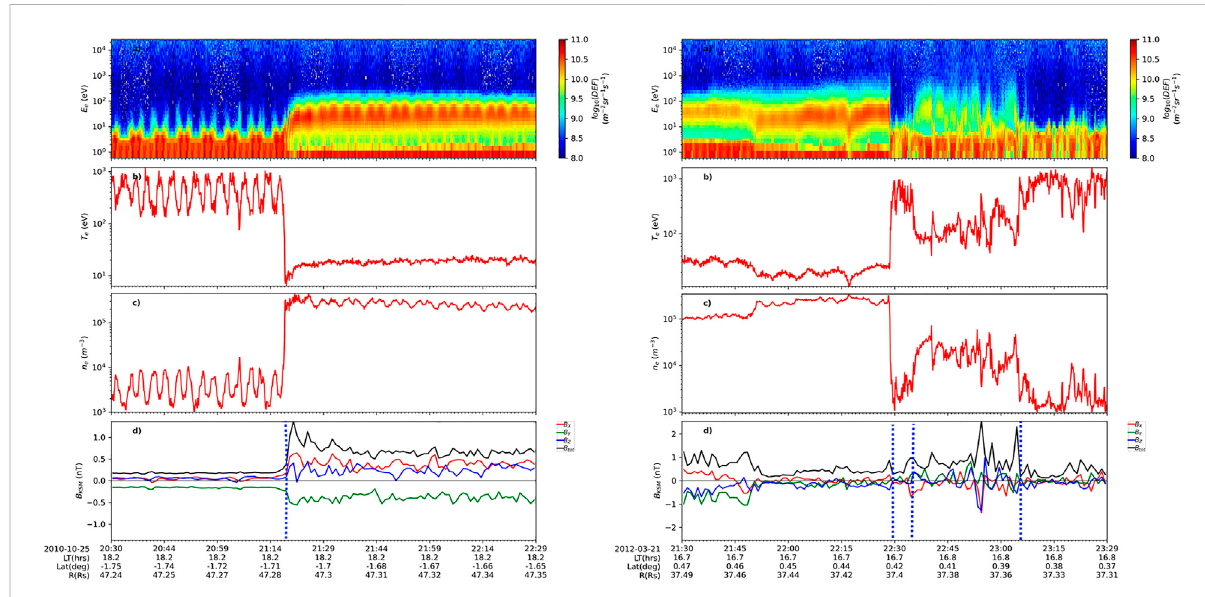
FIGURE 2 Examplebowshockcrossings(markedbyverticalbluedottedlines).Thepanelsare: (A) Electronenergy-timespectrogramofdifferentialenergy fl ux (DEF) from CAPS/ELS anode 5. (B,C) Electron temperature and number density derived from ELS anode 5. (D) The magnitude and KSM components of the magnetic fi eld, with bow shock crossings marked by vertical blue dotted lines. Spacecraft ephemeris data are given below the x -axis of the plots. Note that the derived electron moments within the solar wind are invalid so should not be considered.